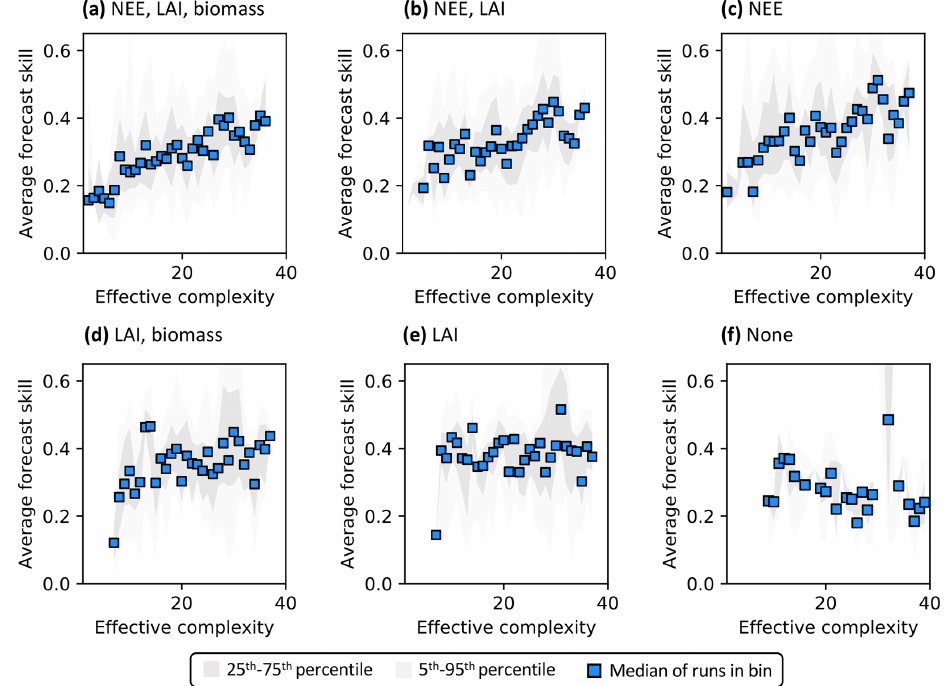
Figure 6. Complexity–skill relationship for NEE predictions, split by combination of assimilated data (title of each subplot). Average forecast skill is computed using the histogram intersection metric. Ordering of subplots reflects the strongest (a) to weakest (f) data